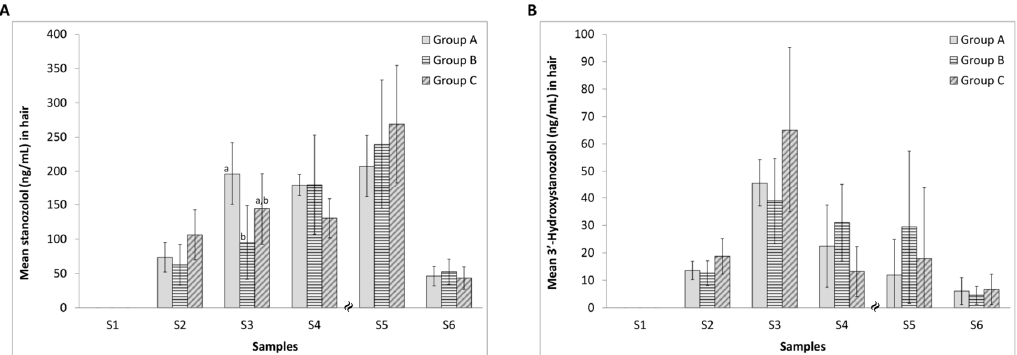
Figure 3. Concentrations of stanozolol ( A ) and 3 ′ -hydroxystanozolol ( B ) in hair samples from group A (5 mg/kg stanozolol only), group B (5 mg/kg stanozolol + 1 mg/kg diclofenac) and group C (5 mg/kg stanozolol + 5 mg/kg diclofenac). Error bars represent standard deviations. Different letters denote statistically significant differences between the treatment groups ( p < 0.05). Effect sizes are given